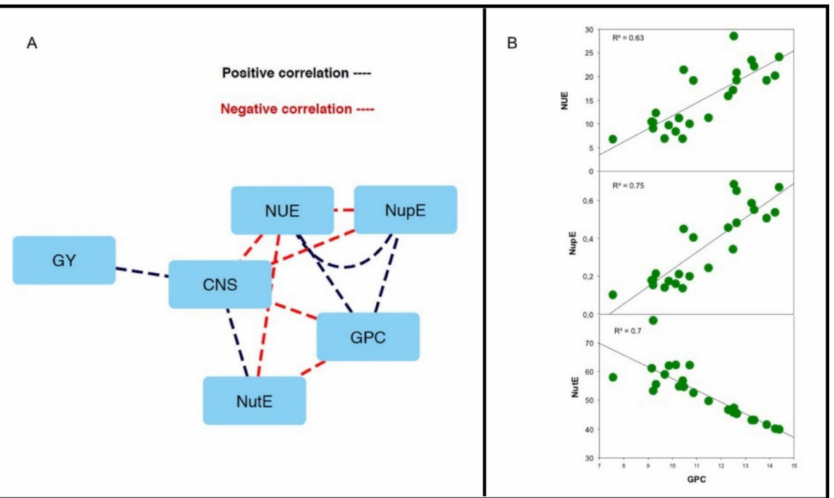
Figure 3. ( A ) Correlation network for NUE traits in durum wheat using four different genotypes and three nitrogen treatments. Line colors represent positive correlations (black) between traits in blue (Pearson’s r > 0.6; p < 0.001) and negative correlations (red). Pearson’s r < − 0.6; p < 0.001. ( B ) Significant correlations between yield and NUE components ( n = 72). Abbreviations: NUE, nitrogen use efficiency; NUpE, nitrogen uptake efficiency; NutE, nitrogen utilization efficiency; CNS, crop nitrogen supply; GPC, grain protein content; GY, grain